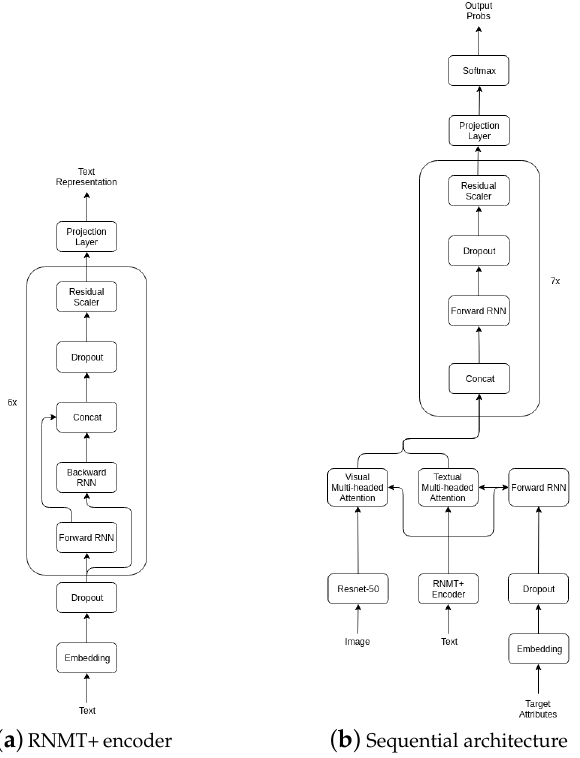
Figure 2. RNMT+ encoder and the sequential